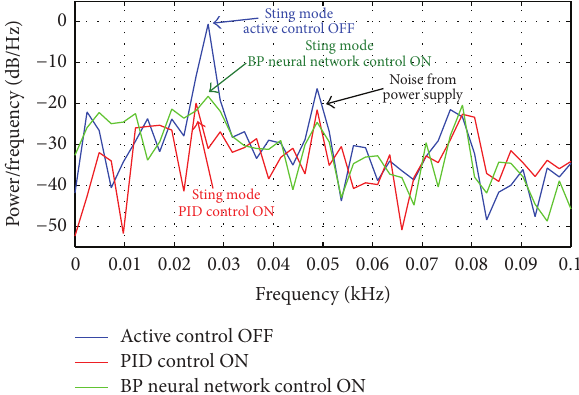
Figure 19: Model response to unstable airflow with active control ON/OFF in wind tunnel evaluation tests.